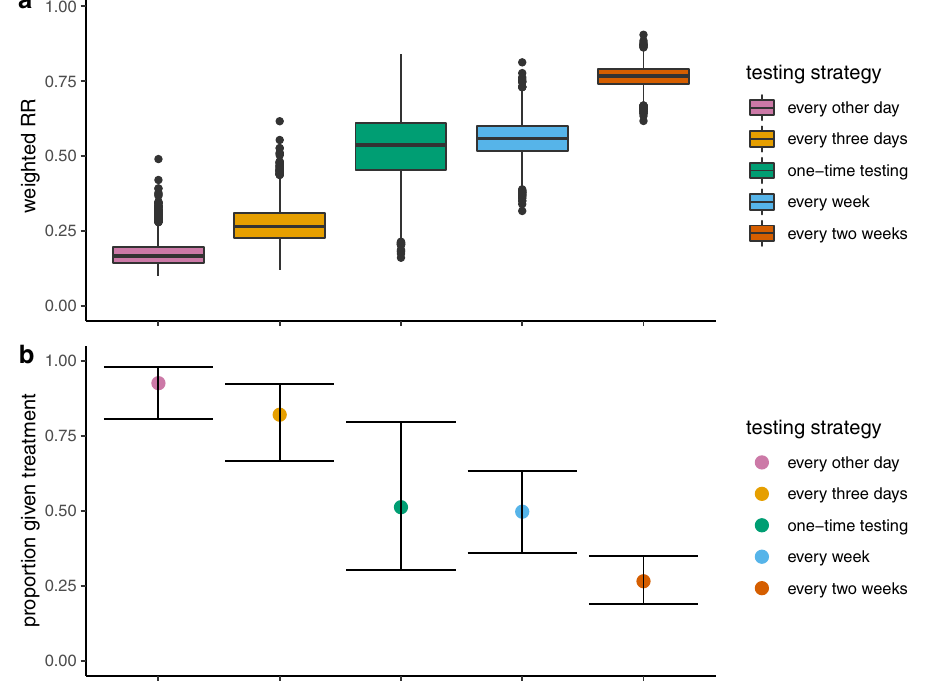
Fig.1|Estimatedweightedhospitalizationriskratios(weightedRR),relativeto thepatientpopulationuntreatedwithnirmatrelvirandestimatedproportions treated, by testing strategy. The weighting of RRs re fl ects the likelihood of testing positive and therefore being treated with nirmatrelvir x days after becominginfected.a DistributionofestimatedweightedRRsofhospitalizationby testing strategy: every other day (pink), every 3 days (orange), one-time testing (green),everyweek(blue),andevery2weeks(darkorange).Mediansaremarkedby solid horizontal lines, each box includes the full interquartile range, and plotted